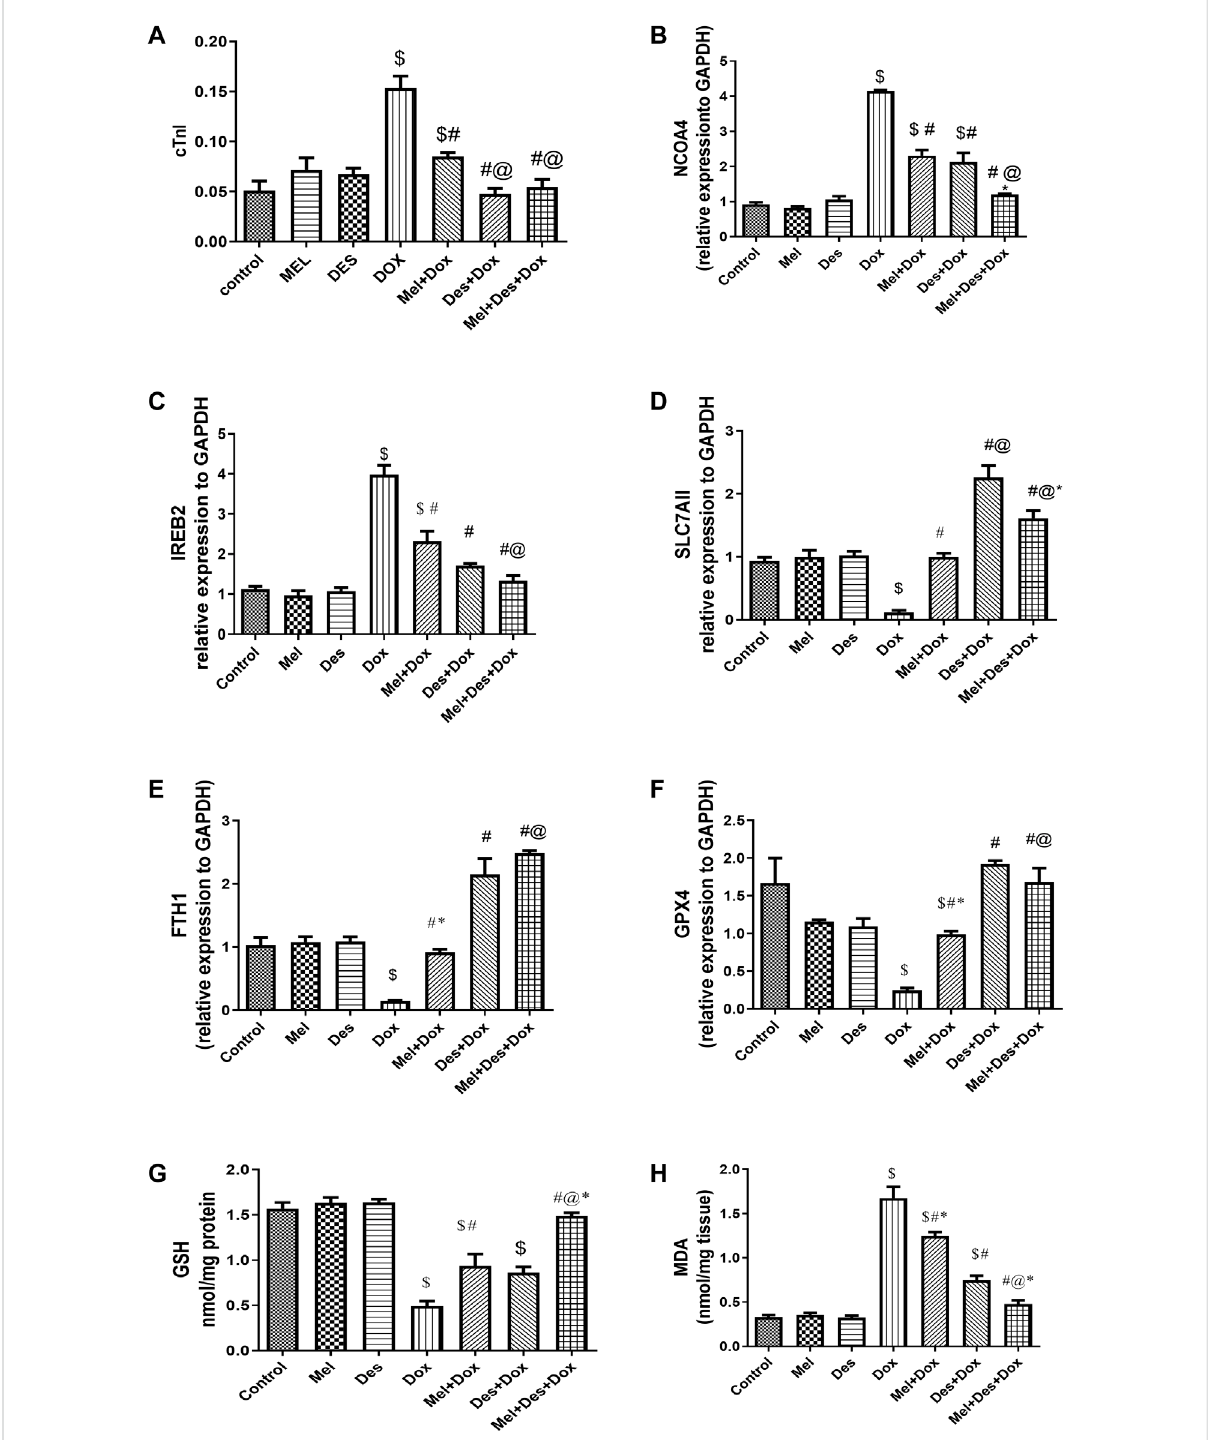
FIGURE 2 (A – H) Biochemical assay results for cTnI, NCOA4, IREB2, SLC7AII, FTH1, GPX4, GSH, and MDA, respectively. $, signi fi cant versus control; #, signi fi cant versus Dox; @, signi fi cant versus Mel-Dox; *, signi fi cant versus Des-Dox. Mel, melatonin; Des, deferoxamine; Dox,